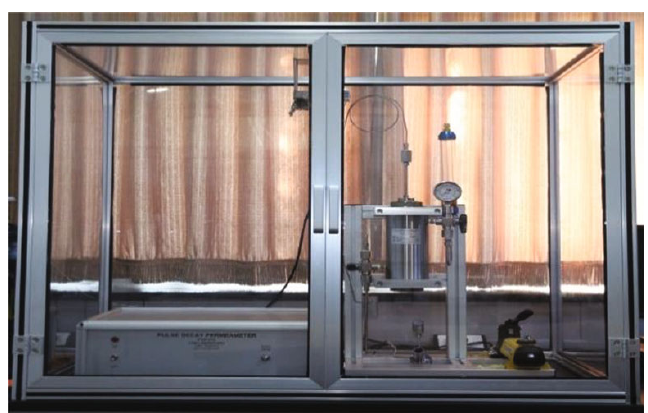
Figure 1: PDP200 permeability measurement apparatus (pressure decay method).